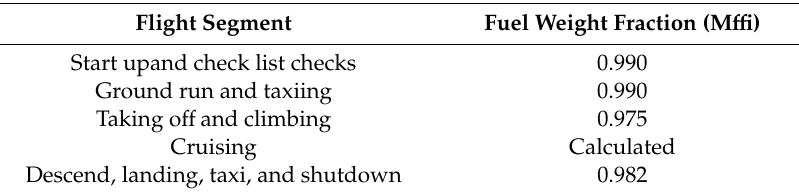
Table 1. Fuel fraction for each segment of a typical flight mission (modified using Roskam [18] as